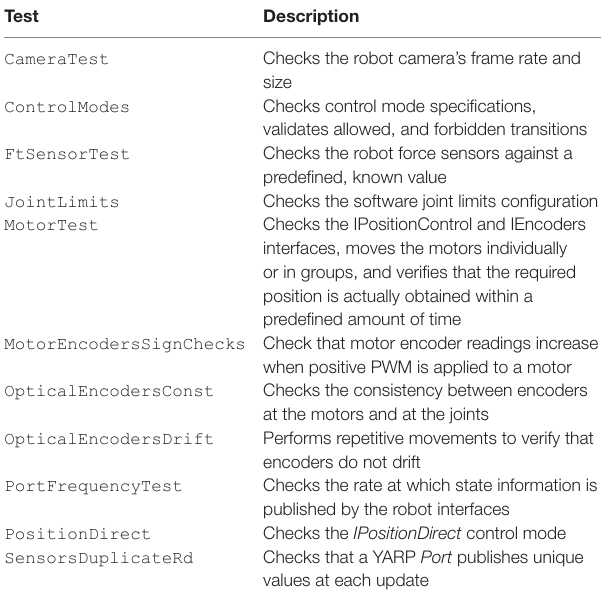
TaBle 2 | some of the test cases which has been developed for the icub